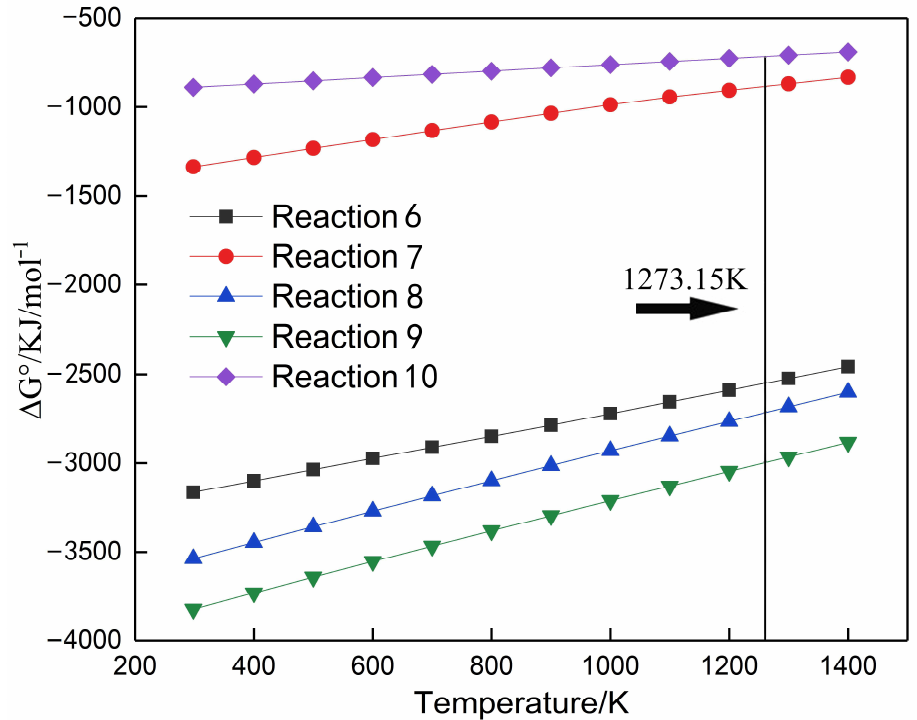
Figure 14. The relationship between temperature and the standard Gibbs free energy of reactions (6)–(10).